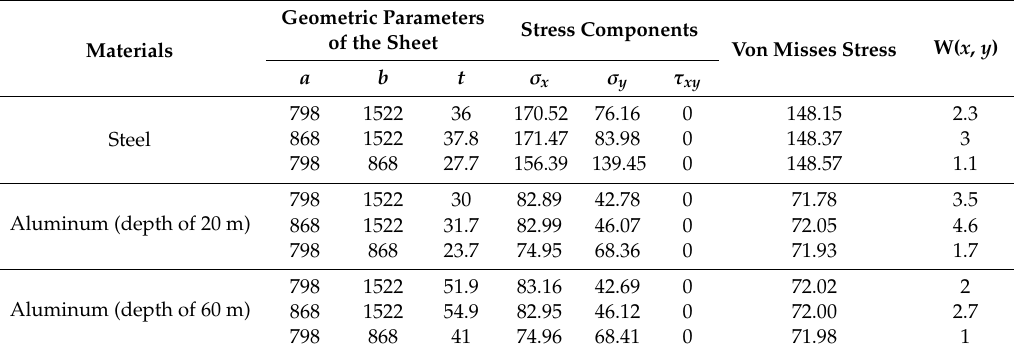
Table 3. Characteristics of compartments made of di ff erent